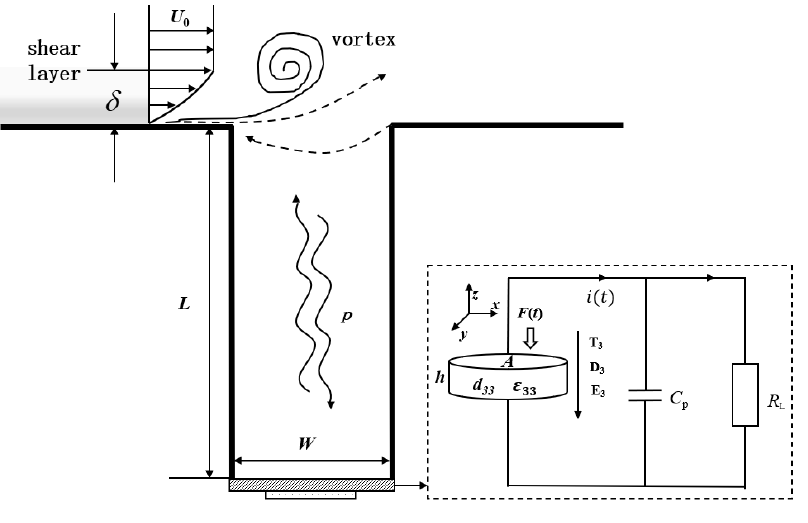
Figure 1. Working principle diagram.